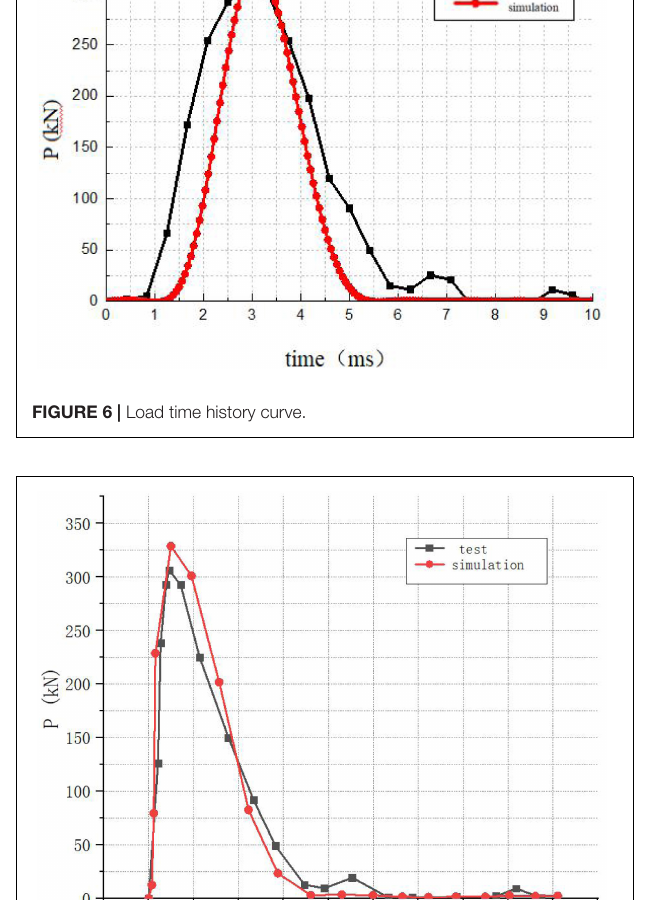
Figure 6 is a comparison of the load time history